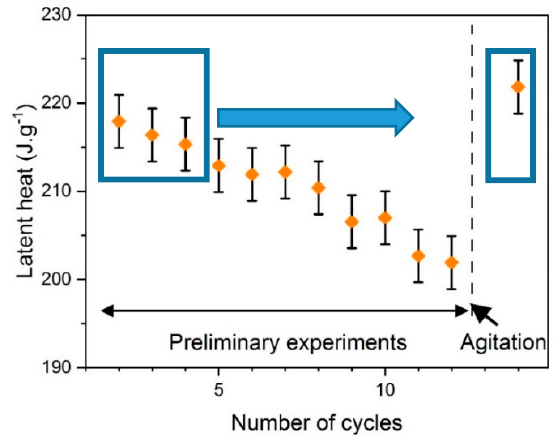
Figure 5. Preliminary evaluation of latent heat of SAT58%. The arrow symbolizes a reset of the properties by agitation (the two rectangles allow for comparison of the latent heat at the beginning of the experiment and after agitation).